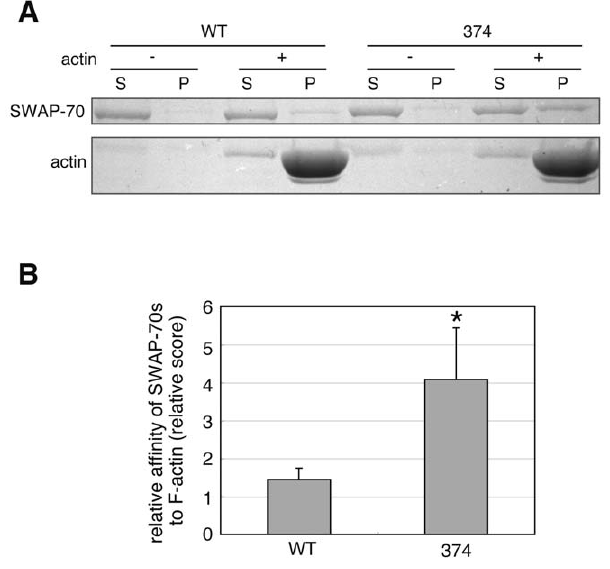
Figure 2. F-actin co-sedimentation assay of SWAP-70s. A, F-actin binding activity of SWAP-70s was examined. His-SWAP-70 (WT) or His- SWAP-70-374 (374) was mixed with ( + ) or without ( 2 ) 20 m M polymerized non-muscle actin. After incubation for 1 hr, samples were ultracentrifuged. Proteins in the supernatant (S) and the pellet (P) were analyzed by SDS-PAGE followed by CBB staining. The faint bands seen at the position of actin in the lane of actin ( 2 ) are the degradation product of His-SWAP-70-WT/374. B, The same experiments as in A were done for five times and the amount of SWAP-70 in each lane was quantified. Relative affinity of SWAP-70s to F-actin were calculated as described in Materials and Methods. Results from five independent experiments are presented as the means. The error bars indicate standard deviation (* P , 0.02; t-test).